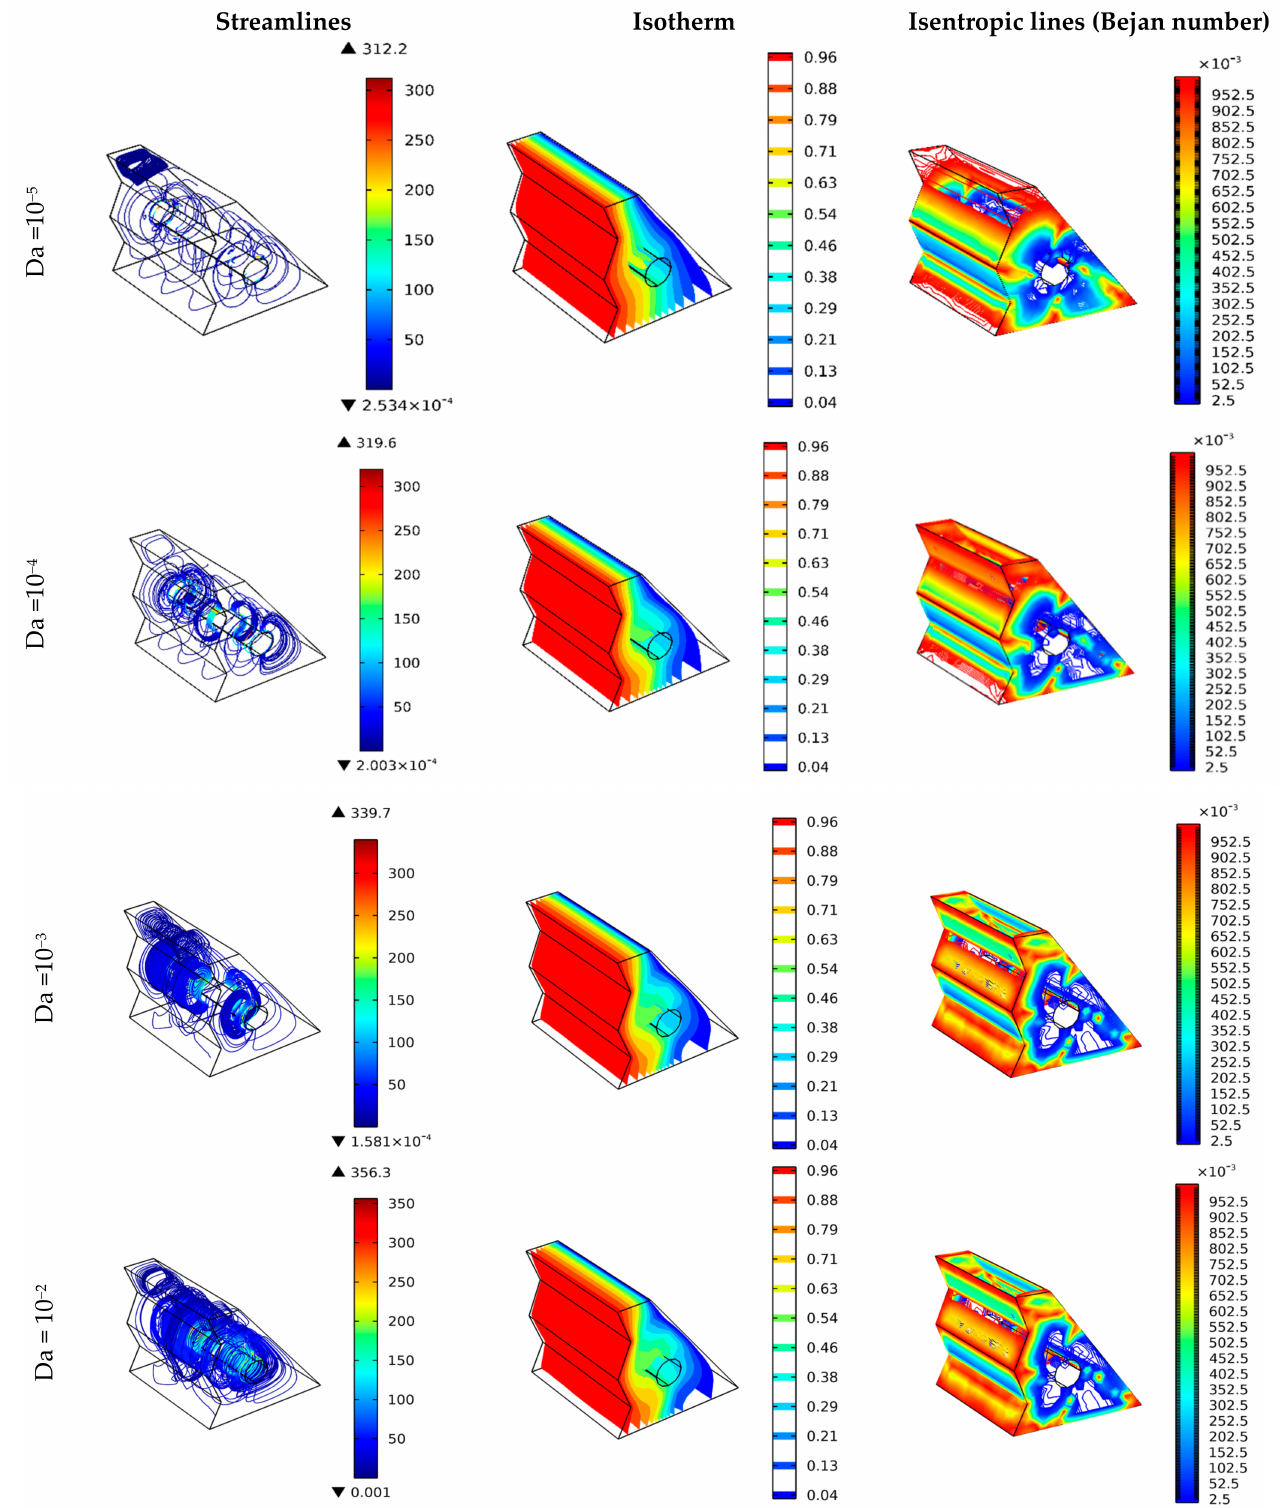
Figure 3. Three-dimensional surface plots to show the effect of Darcy number (permeability) on the streamlines, temperature in terms of dimensionless isotherms, and Bejan